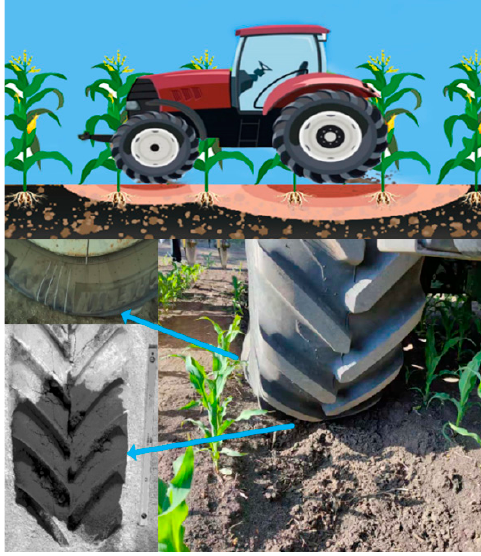
Figure 2. Tire deformation and ground contact area.